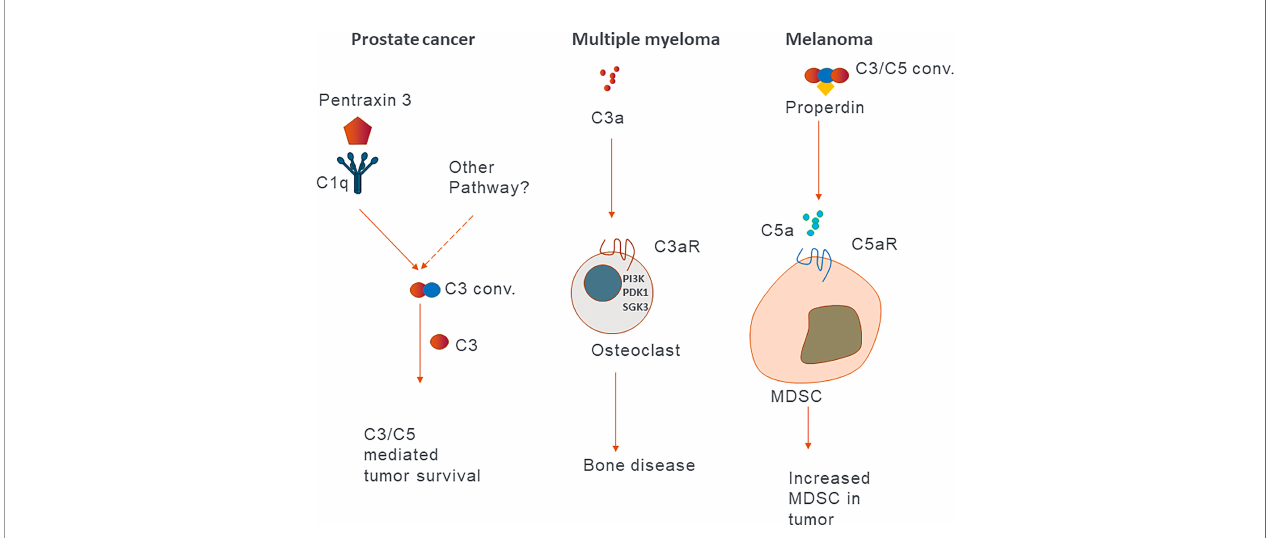
FIGURE 2 | Examples of the effect of extracellular complement in different cancers. Schematic representation of published mechanisms describing different roles of complement proteins in different